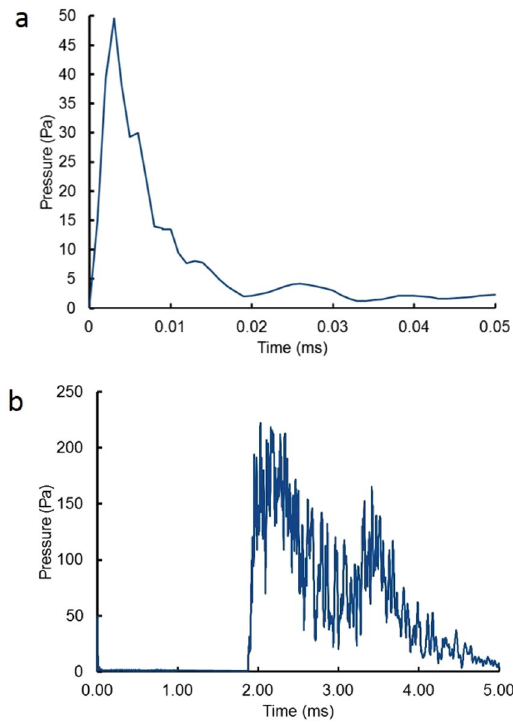
Figure 7. ( a ) The average of four pulses at 5 meters from the 112-J pulser and showing the ~10- μ s duration shock wave and ( b ) the ~1-ms duration secondary